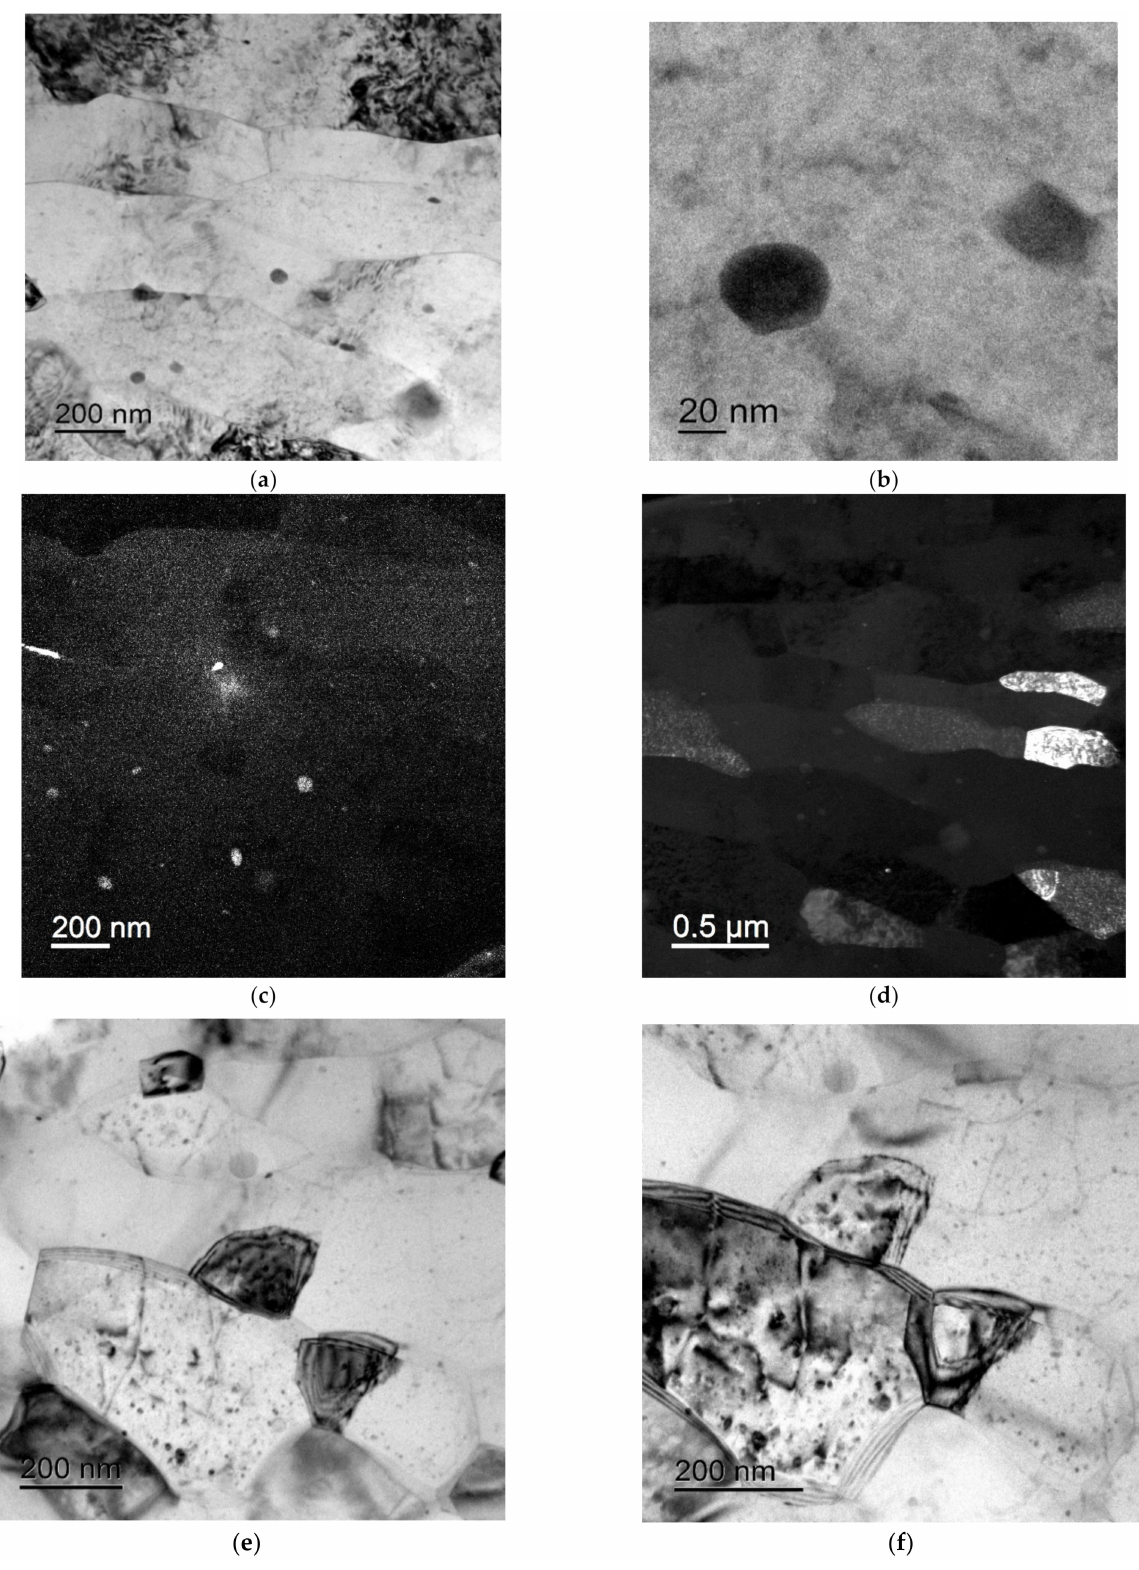
Figure 5. Al 3 (Zr,Sc) nanoparticles in the central part ( a – d ) and near the interphase boundary Al-Cu ( e , f ) of the sample bimetallic wire that was made from Alloy #3: ( a , b ) bright-field images; ( c , d ) dark- field images of different areas.